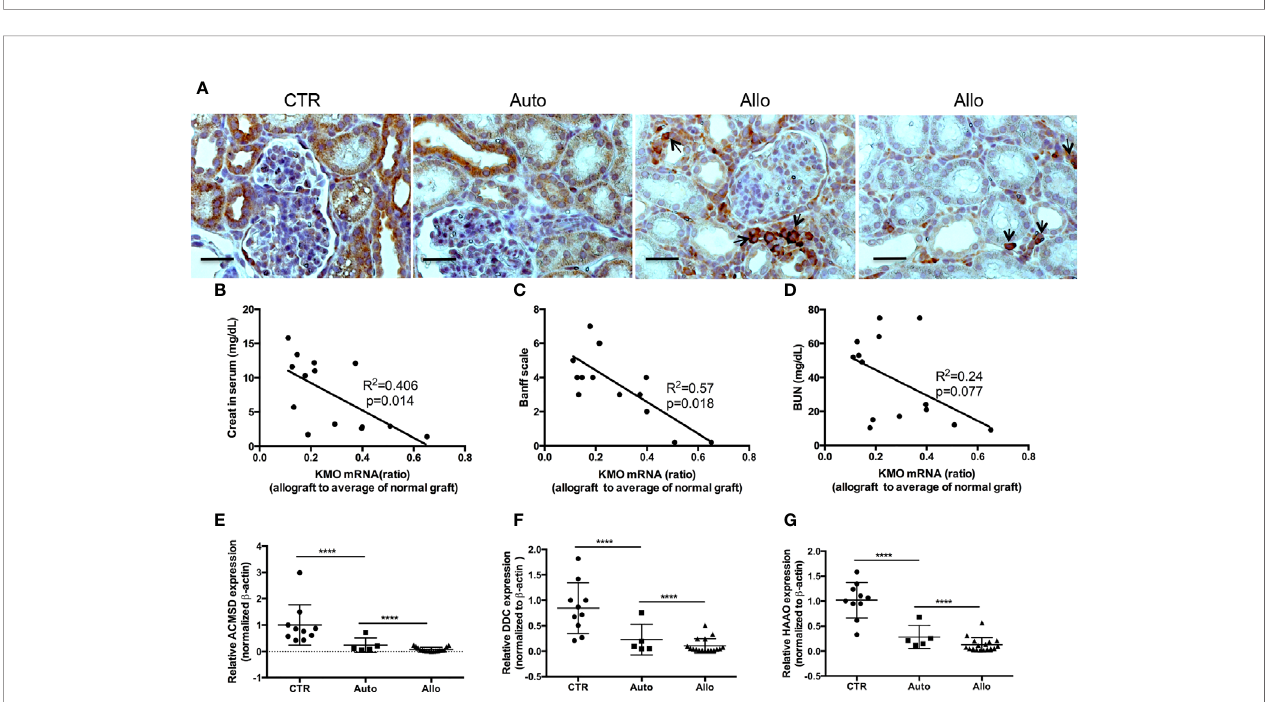
FIGURE 2 | The expression of KMO and other kynurenine metabolic enzymes in grafts. KMO mRNA in grafts were determined by real-time PCR via using three pairs of PCR primers which amplify the 5 terminal (161 – 265 bp), middle (493 – 600 bp), and 3 terminal (1,239 – 1,349 bp) speci fi c sequence of KMO gene; the real-time PCR from three pairs of primers showed almost the same result. b -actin mRNA for normalization, an average of KMO mRNA was calculated from the results of real-time PCR from 19 normal pig kidneys. The ratio of KMO mRNA in allograft rejection to the average of KMO mRNA in normal kidneys is KMO mRNA fold alterations. (A) IHC of KMO on graft tissue section. (B – D) Correlation of KMO mRNA ratio in allograft rejection with serum creatinine, allograft Banff scale, and BUN in recipients. (E – G) Quantitative analysis of HAAQ, DDC, and ACMSD in grafts. **** P < 0.0001, one-way ANOVA, Auto versus CTR, Allo versus Auto. The scale bar is 500 µm.